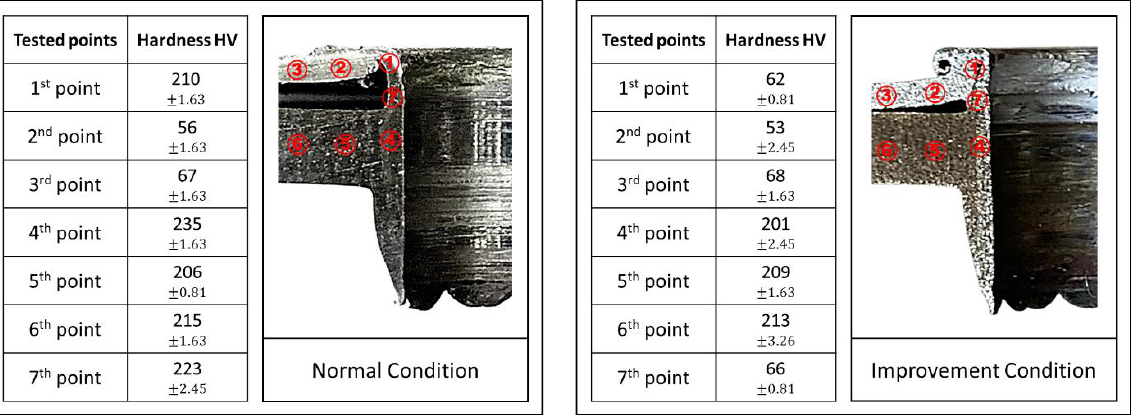
Figure 13. Cross-section and close-up views of back-extruded materials zones for friction-drilled joints under normal and improvement conditions.